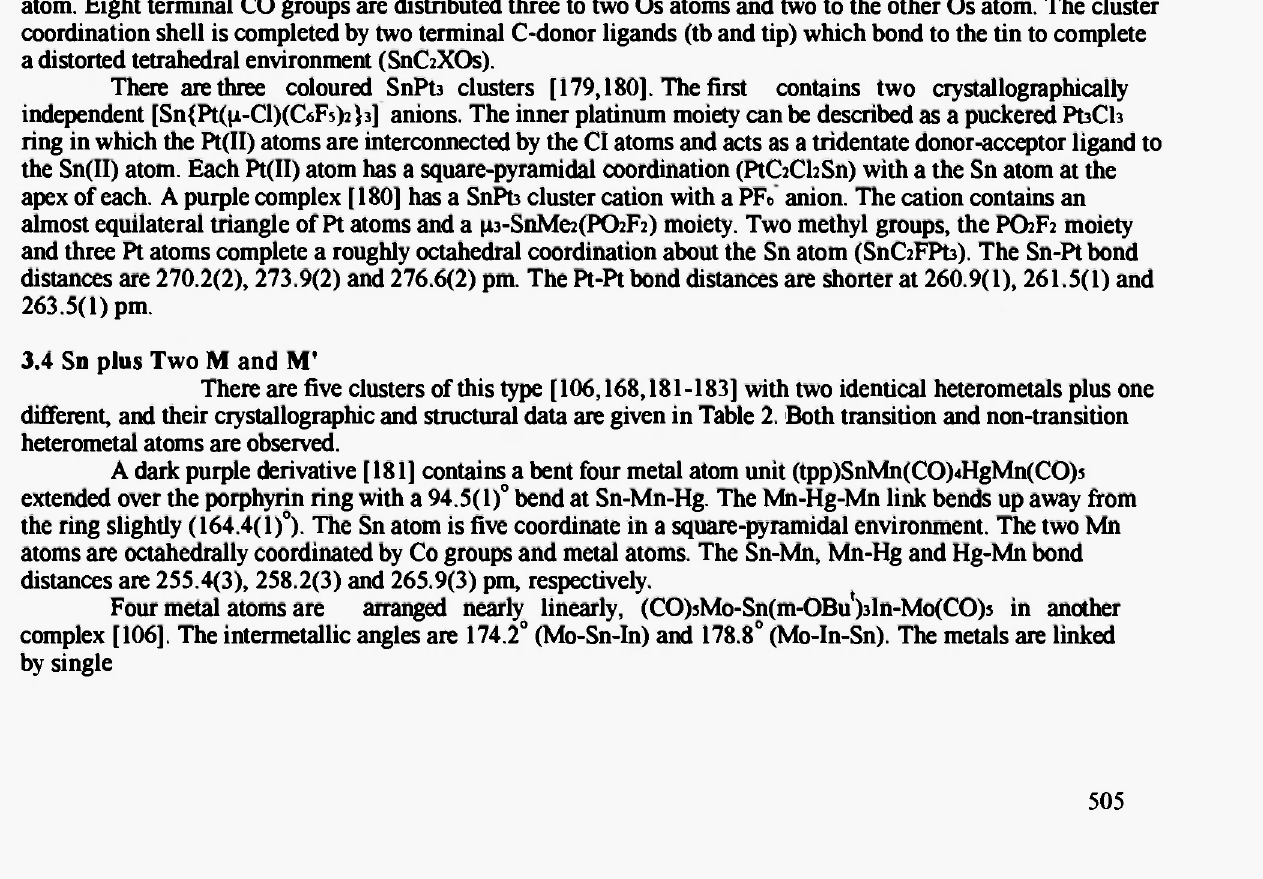
Fig.7. Structure of OjüSn^-H)i(CO)^V-OCCH(SiMej)j}{CH(SiMej)i}